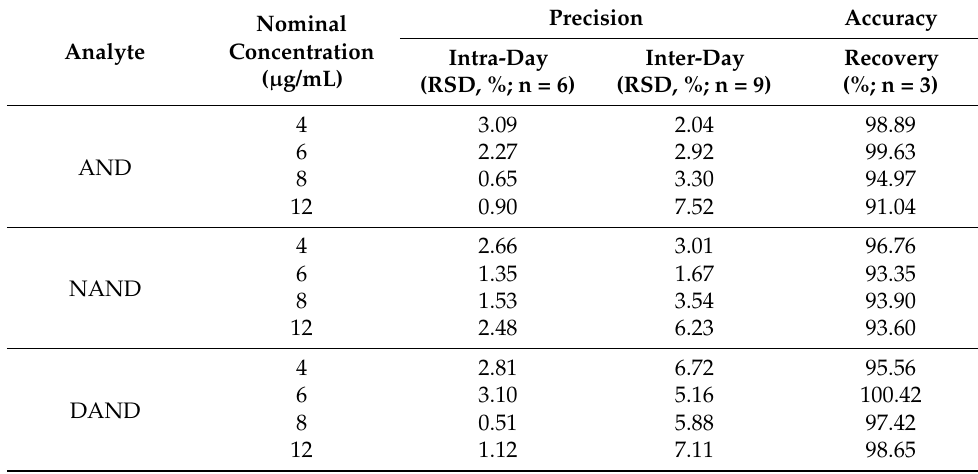
Table 4. Precision and accuracy data.